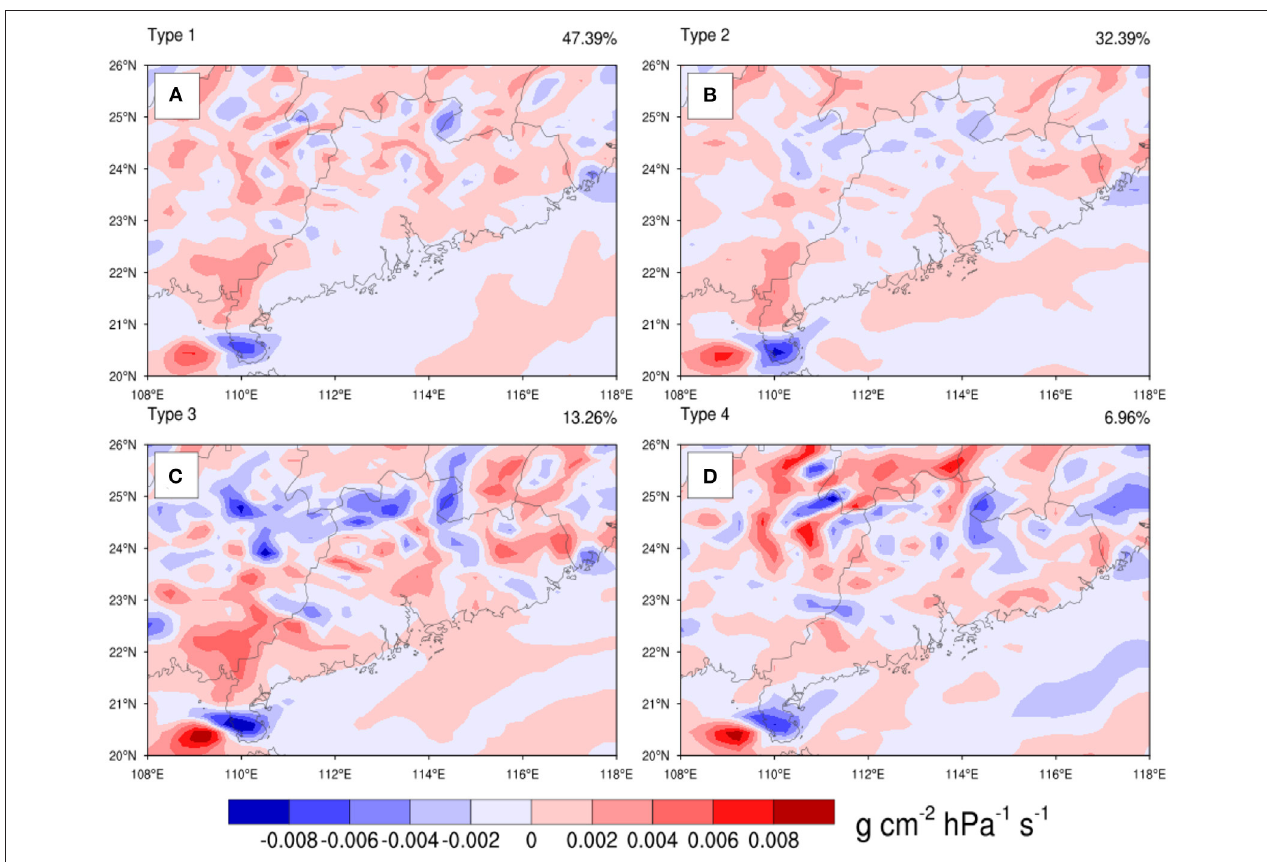
FIGURE 7 | 850hPa water vapor flux divergence for four weather types: (A) Type 1, (B) Type 2, (C) Type 3, and (D) TYPE